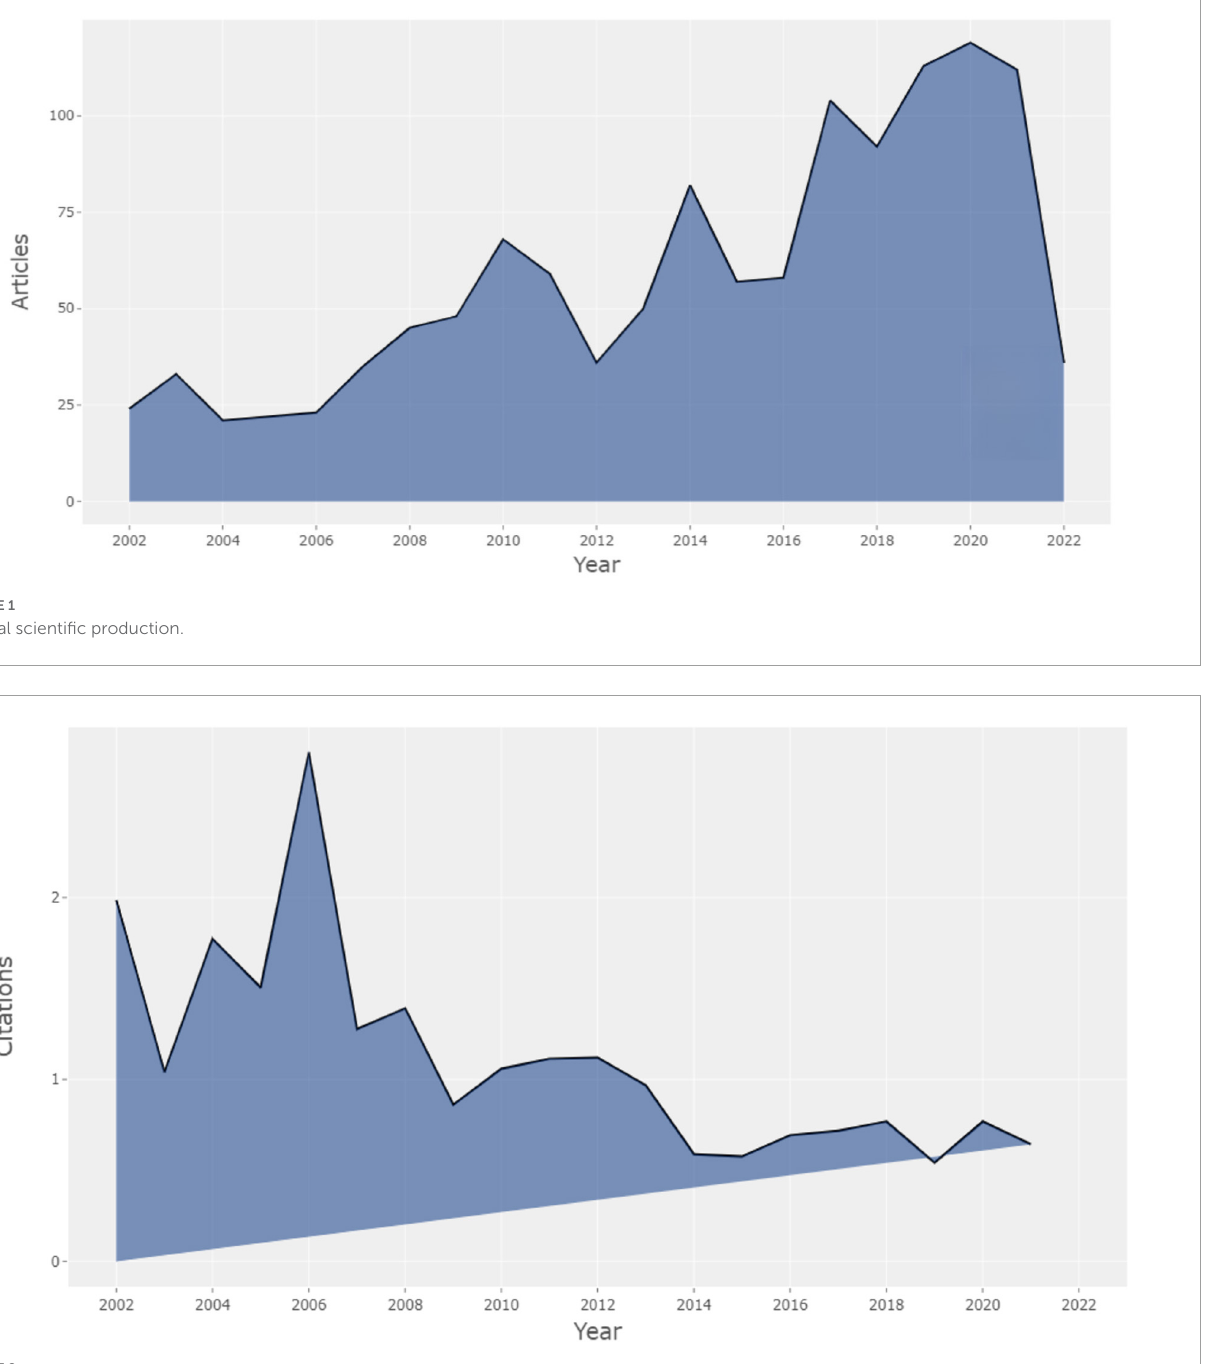
FIGURE2 Average article citations per